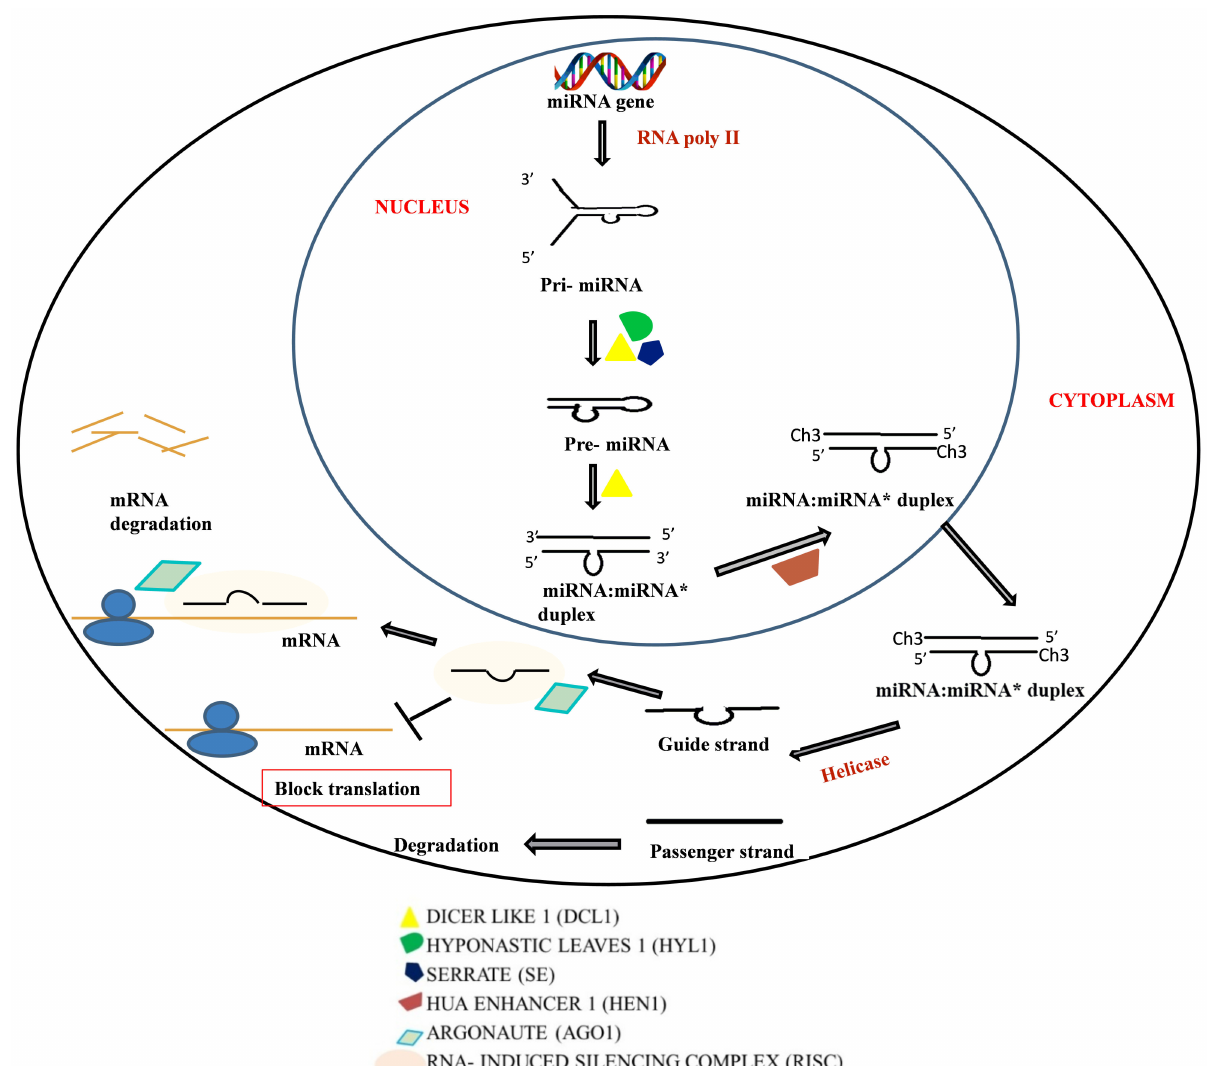
Figure 1. Mechanism of miRNA biogenesis and gene silencing. The miRNA biogenesis commences with the transcription of miRNA genes into pri-miRNA by RNA polymerase II, which is further subjected to primary and secondary processing via the enzyme complex of DCL-1, SE, and HYL1 leading to the generation of pre-miRNA and an miRNA/miRNA* duplex, respectively. Further the HEN1-mediated methylation at the 3 (cid:48) -OH end leads to the export of the duplex to the cytoplasm. In the cytoplasm, the passage RNA strand is degraded and the guide strand from the miRNA-inducing silencing complex (miRISC) directs the degradation or translation inhibition of the target